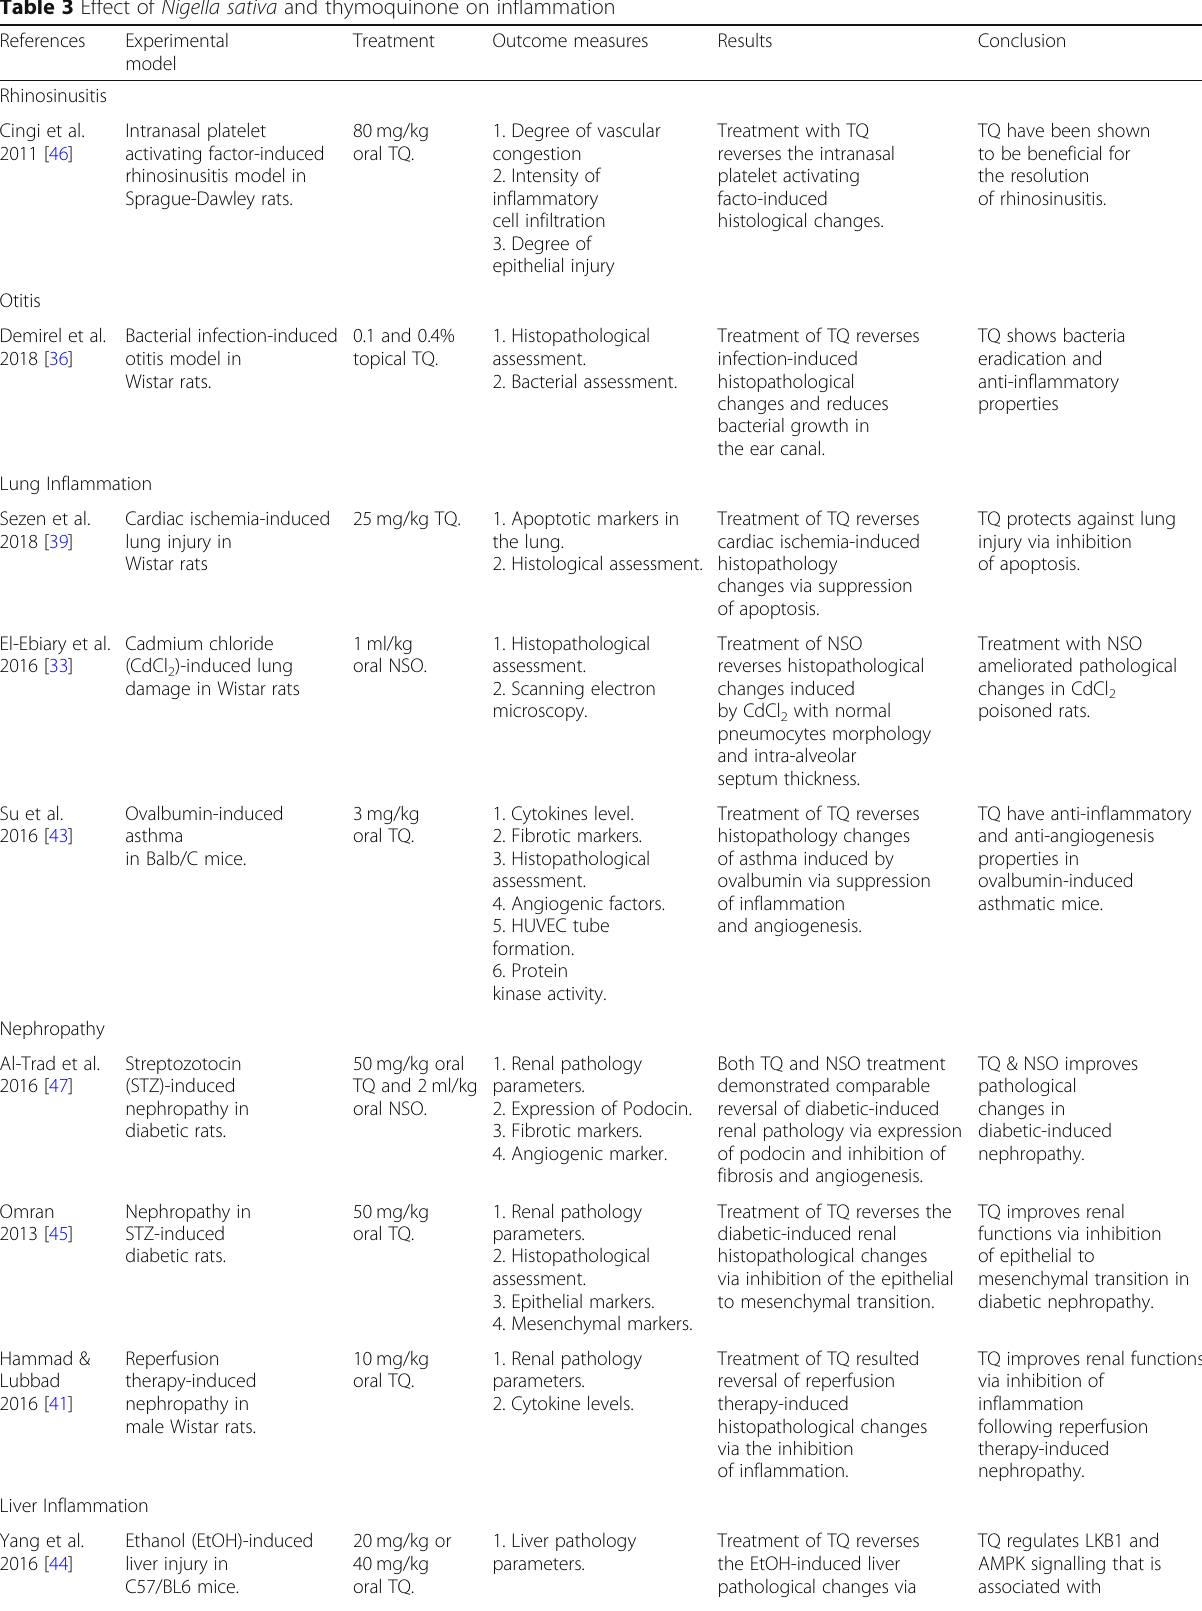
Table 3 Effect of Nigella sativa and thymoquinone on